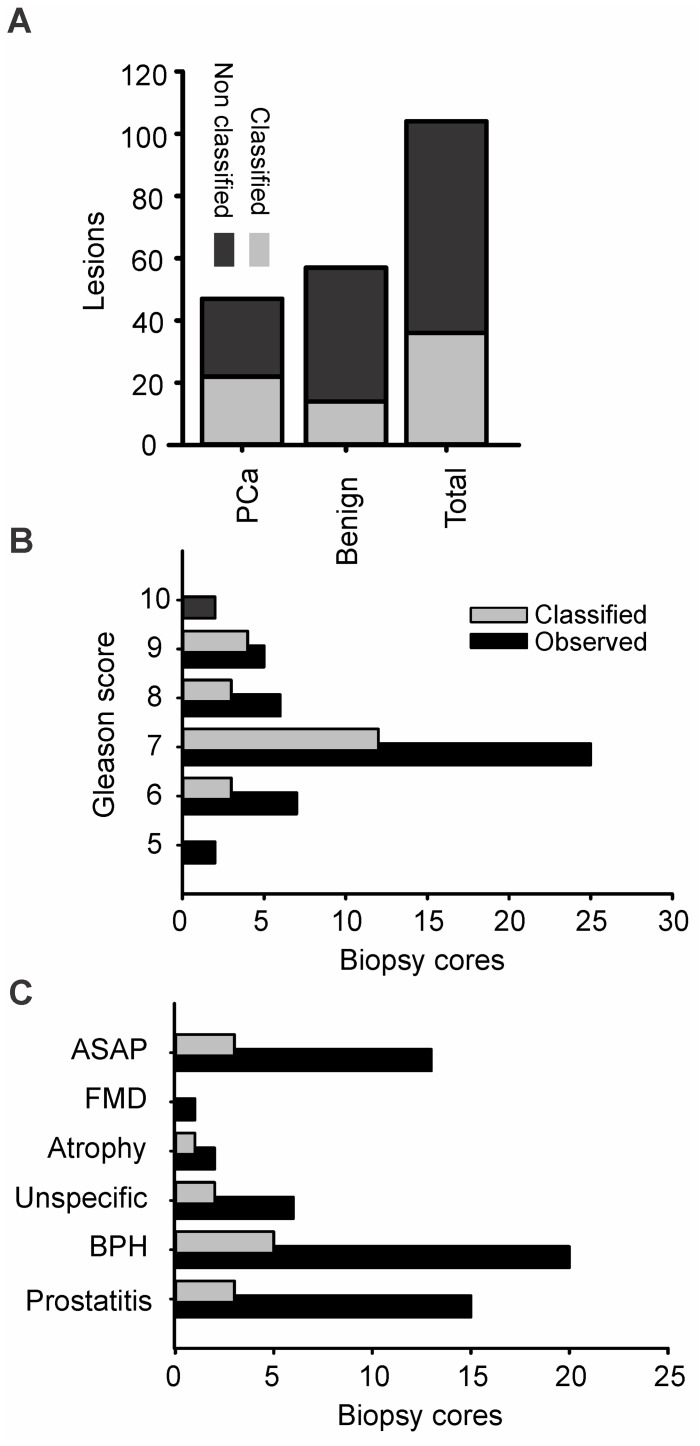
Classification of malignant and benign biopsy cores.(A) Proportion of classified to non classified malignant and benign lesions. From 104 mixed type cores 36 were classified, from those (classified/total) 14/57 were benign and 22/47 malignant. (B) The classification was independent of the Gleason grade, P 0.713 R 0.193 Pearson correlation (C) Classification of benign lesions. ASAP, Atypical Small Acinar Proliferation; FMD, Fibromuscular Dysplasia; BPH, Benign Prostatic Hyperplasia.